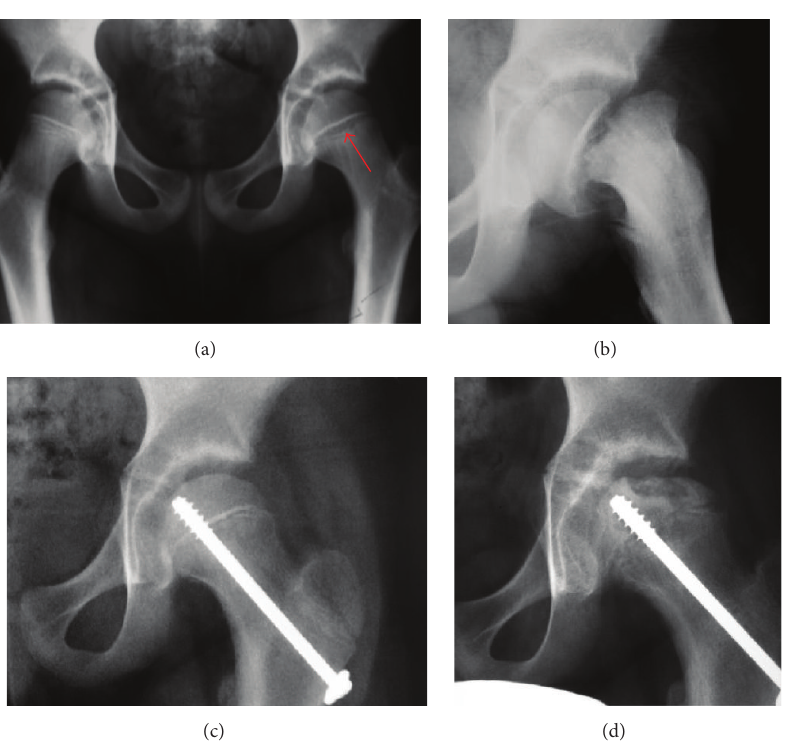
Figure 4: (a) X-ray of a 10-year-old child with left hip pain. It was considered normal at emergency despite the widening of the left physis (arrow). Two weeks later epiphysiolysis was evident (b). Despite appropriate surgical reduction (c) osteonecrosis developed and femoral head collapsed 1 month later